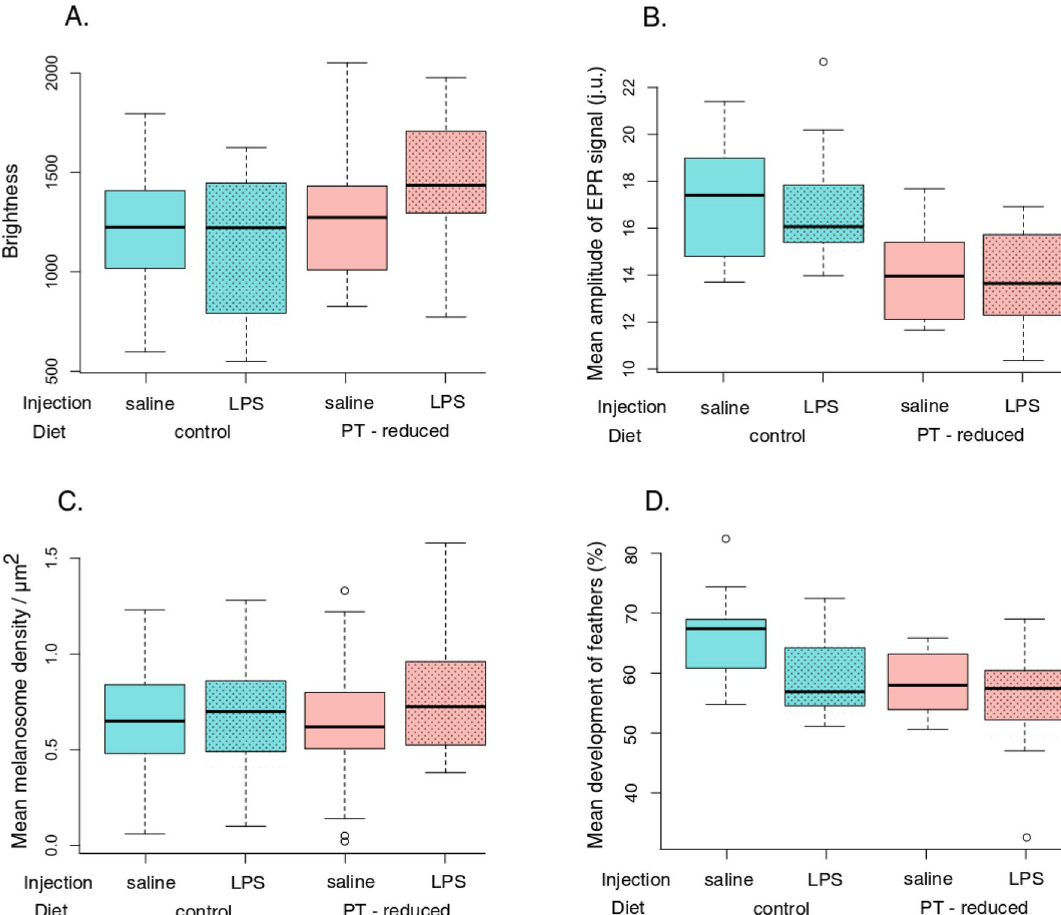
Figure 2. Feather parameters in different experimental treatment. Boxplot of mean brightness ( A ), mean amplitude of the EPR signal ( B ), mean melanosome density per µm 2 ( C ), and mean development of feathers ( D ) of bib feathers of house sparrow fed control or PT-deficient diet and immune challenged (LPS) or injected by saline vehicle (control